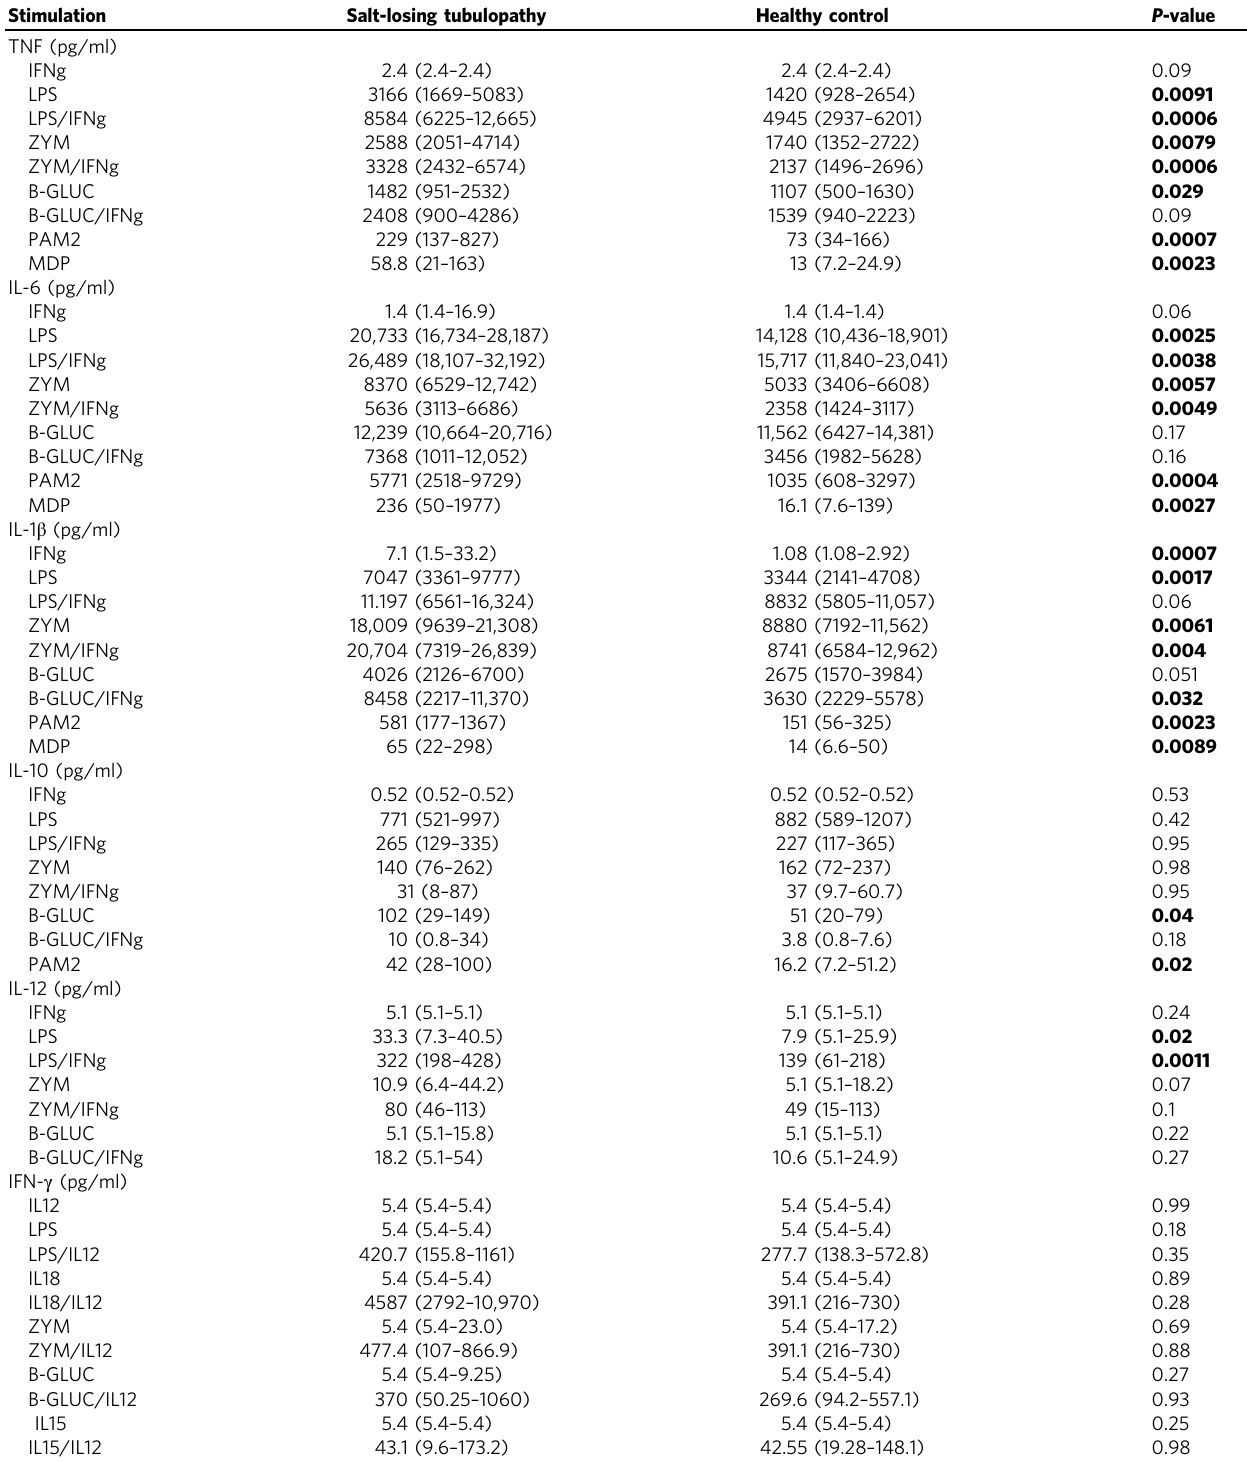
Table 2 Whole blood cytokine stimulation assays to assess innate cytokine responses in salt-losing tubulopathy patients. Stimulation Salt-losing tubulopathy Healthy control P